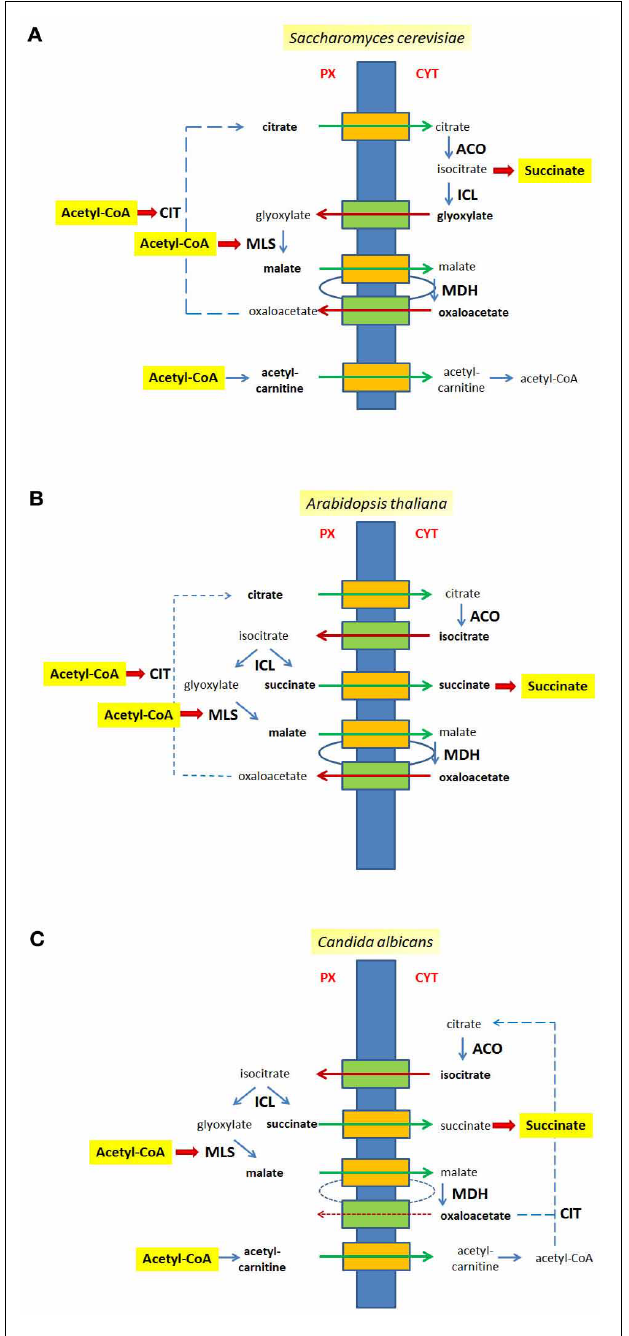
FIGURE 2 | Metabolites of the glyoxylate cycle crossing the peroxisomal membrane. The peroxisomal membrane facilitates the transfer of small metabolites. The transport of glyoxylate cycle intermediates and of C 2 -units is shown for S. cerevisiae (A) , A. thaliana (B) , and C. albicans (C) . Hypothetical pore-forming proteins permitting the export of intermediates are colored orange, hypothetical pore-forming proteins permitting the import of intermediates are colored green. Broken lines are drawn to close the glyoxyate cycle. Intermediates that cross the peroxisomal membrane are indicated bold. Px , peroxisomal side of the membrane, Cyt , cytosolic side of the